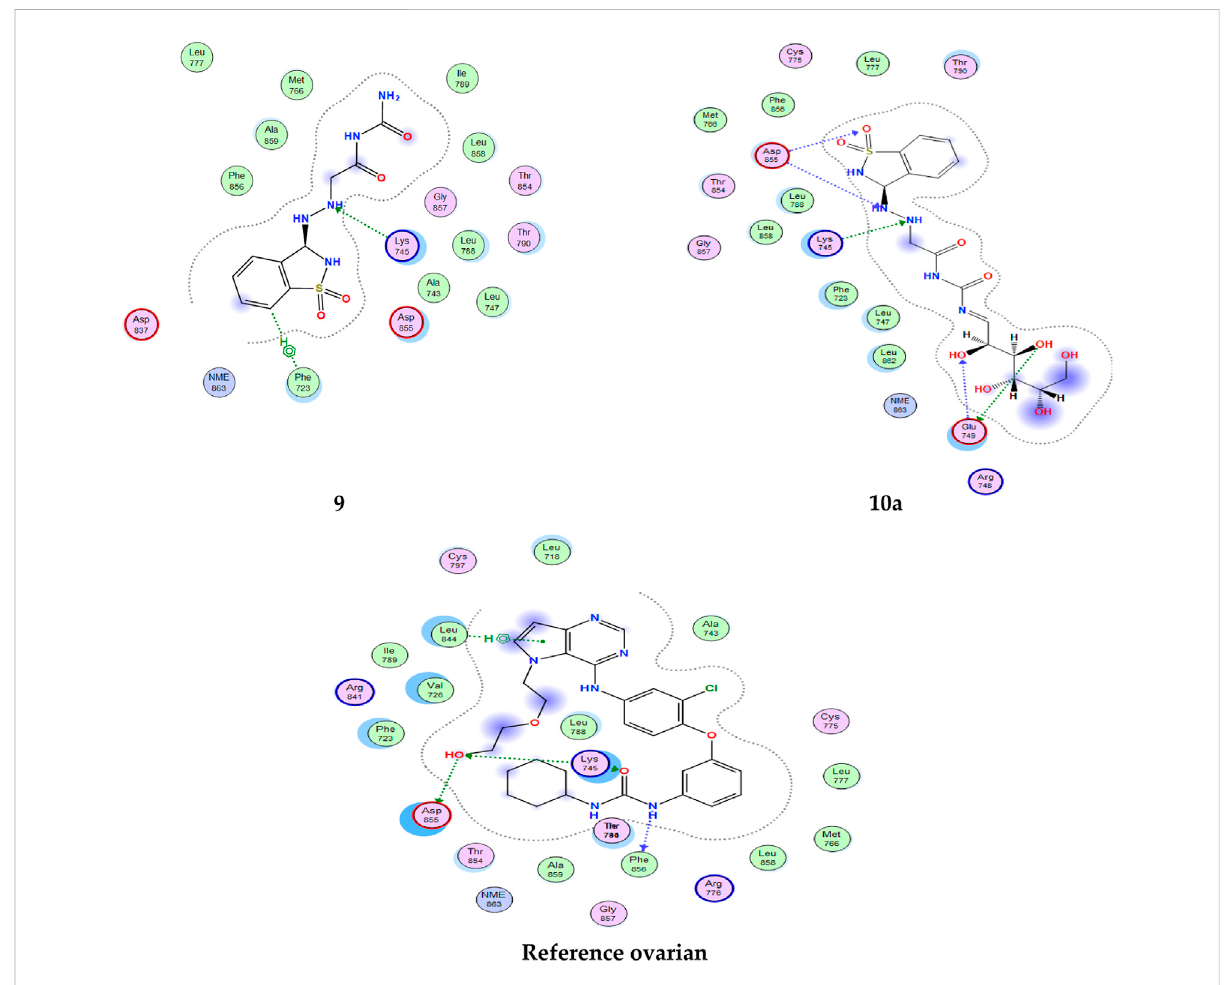
FIGURE 6 2D interaction of all compounds with 3W2S ’ ovarian cancer protein.